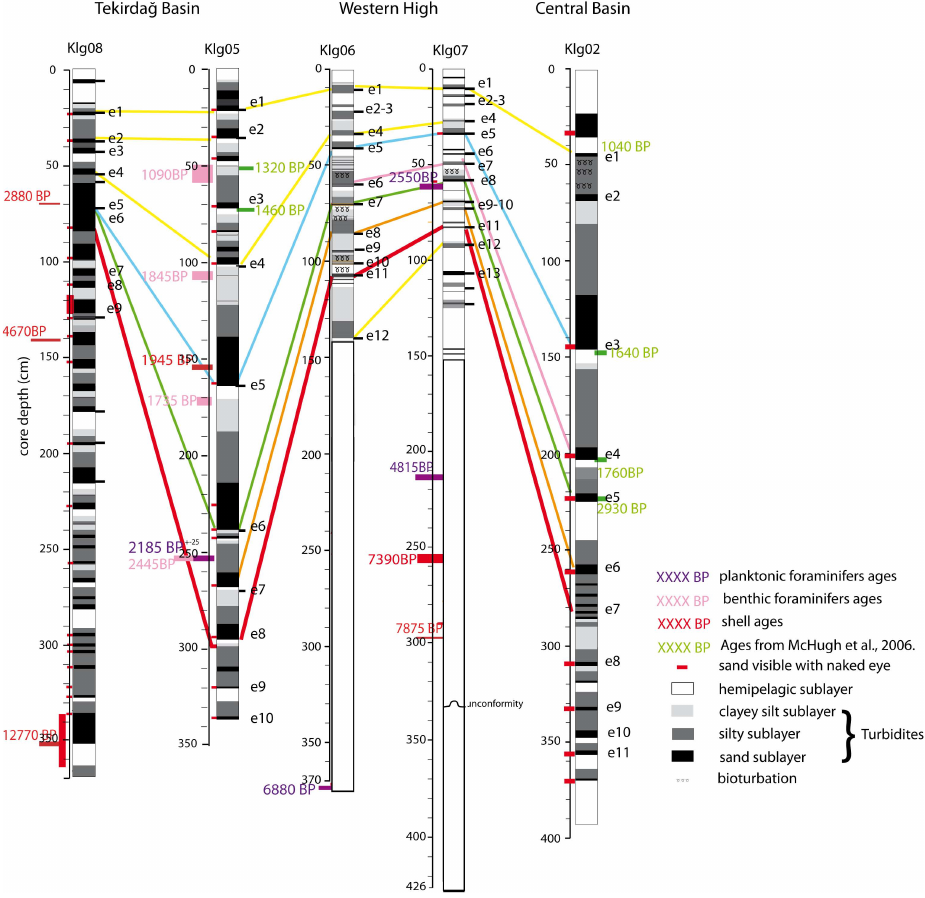
Fig. 10. XRF Correlation obtained in Fig. 8 for the cores Klg08, Klg05, Klg06, Klg07 and Klg02. Lines between cores represent the correlative sedimentary events identified in Figs. 4, 5, 9. Uncalibrated radiocarbon ages for shells (in red), planktonic foraminifers (in purple), benthic foraminifers (in light pink) are presented in Table 2. Radiocarbon ages in green are from McHugh et al.